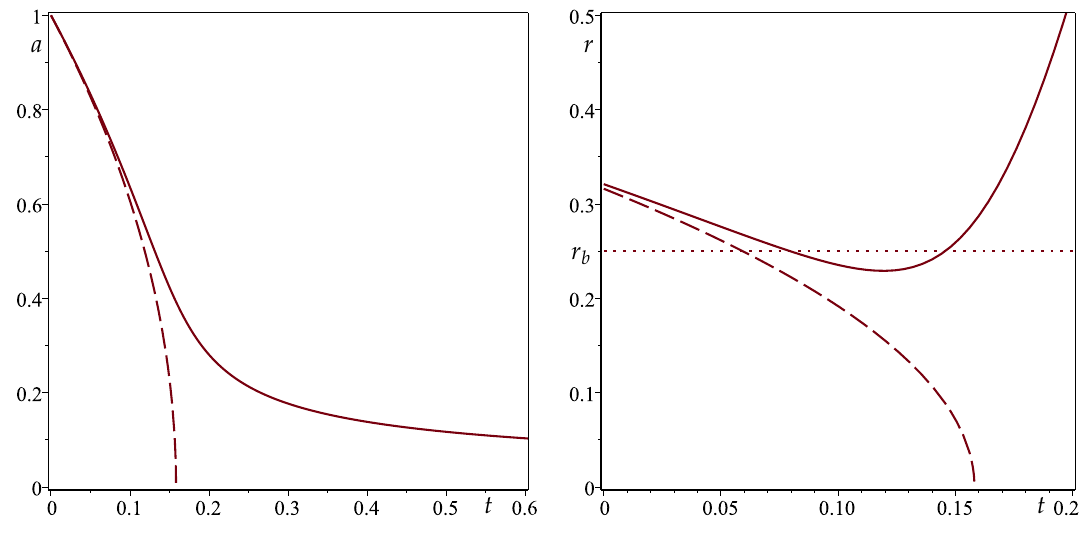
Figure 8. Comparison between classical homogeneous dust collapse (dashed lines) and semi-classical collapse leading to an almost static compact remnant (solid lines) for a fluid approaching a ‘dark energy’ equation of state. Left panel : Comparison of the scale factors a ( t ) . In the classical case a goes to zero in a finite time. In the semi-classical case a goes to zero as t goes to infinity. Right panel : Comparison of the apparent horizon curves r ah ( t ) . In the classical case r ah goes to zero in a finite time. In the semi-classical case the apparent horizon reaches a minimum value and then tends to infinity as t grows, thus indicating that eventually it crosses the boundary of the collapsing object (indicated here by the dotted line of the co-moving radius r b ). The plots have values of the parameters chosen as follows: M 0 = 10, λ = 1/3, ρ cr = 1000, r b = 0.25. Note that in order to have the initial boundary surface not trapped one has to consider r b < r ah ( 0 ) so that if r b is smaller than the minimum value of r ah no trapped surfaces